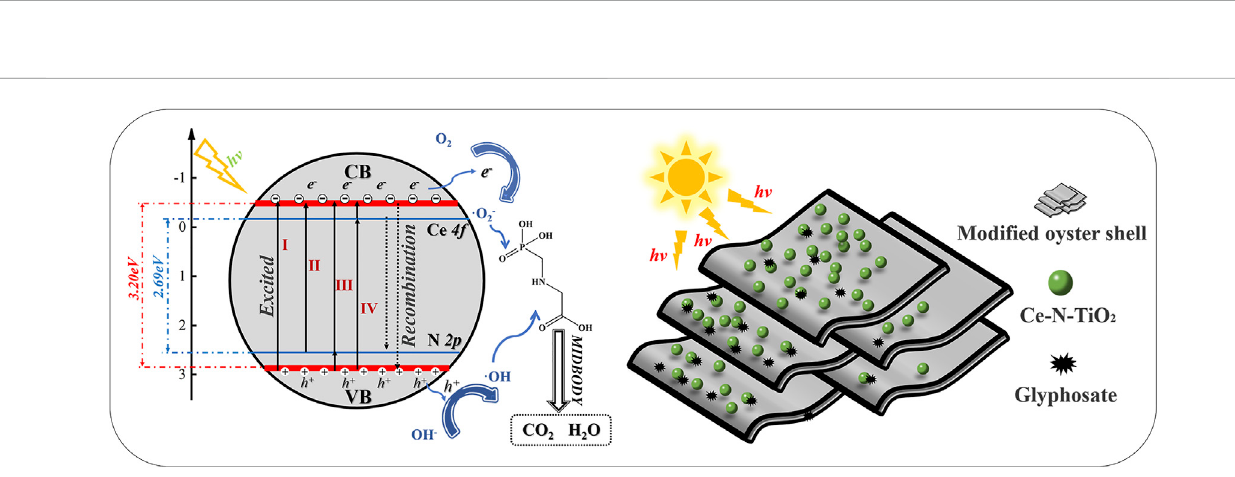
FIGURE 10 Proposed visible-light photocatalytic glyphosate mechanism by the